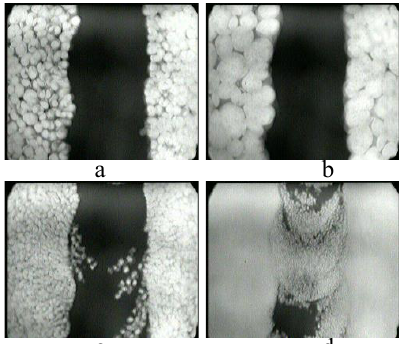
Fig. 3. The defects in welds of steel pipes: optical (a) and magneto-optical (b, c) images; orthogonal (b) and longitudinal (c) excitation of eddy